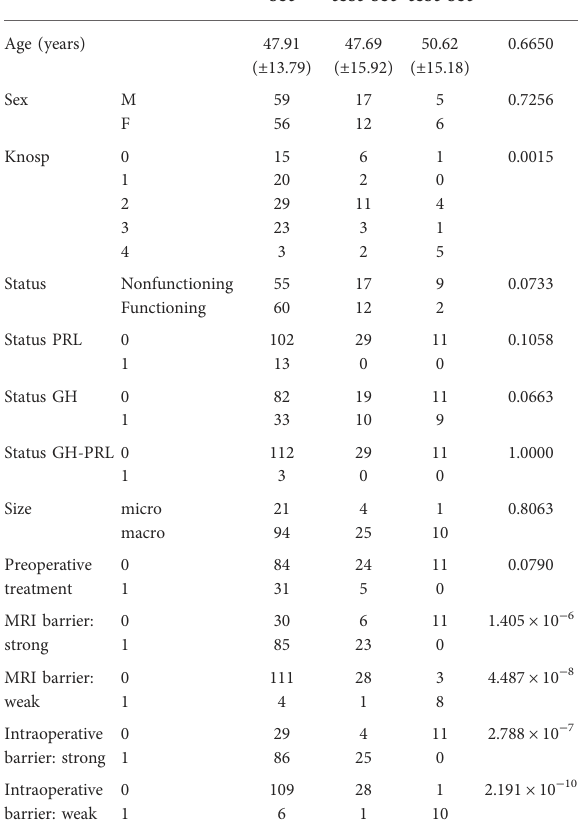
TABLE 2 Accuracy metrics. Isolation forest Accuracy: 0.7